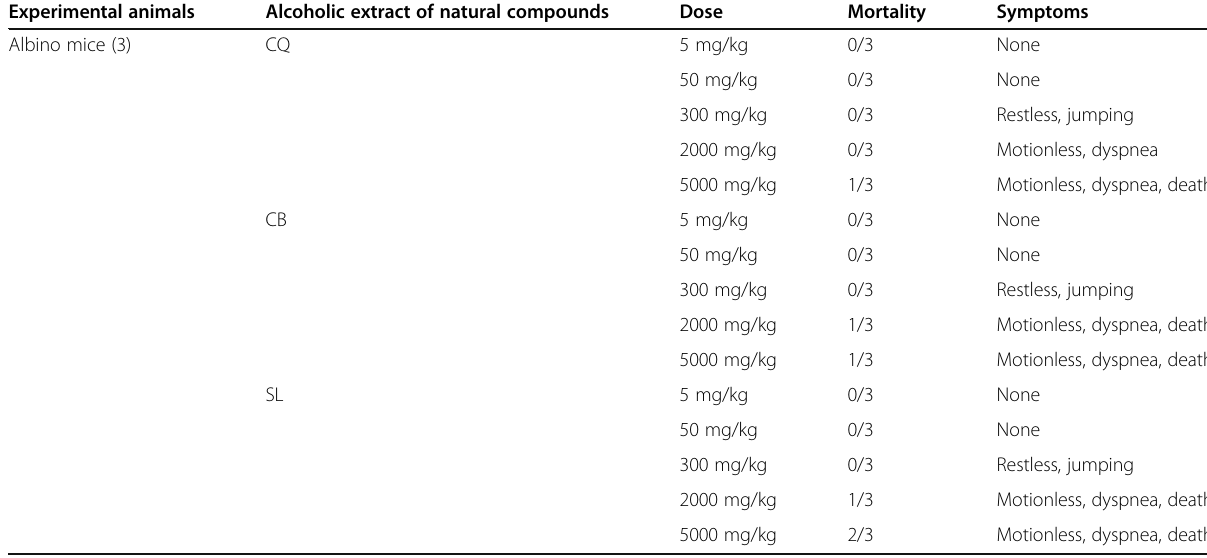
Table 3 The result of acute toxicity of alcoholic extracts of natural compounds on Wistar albino rats Experimental animals